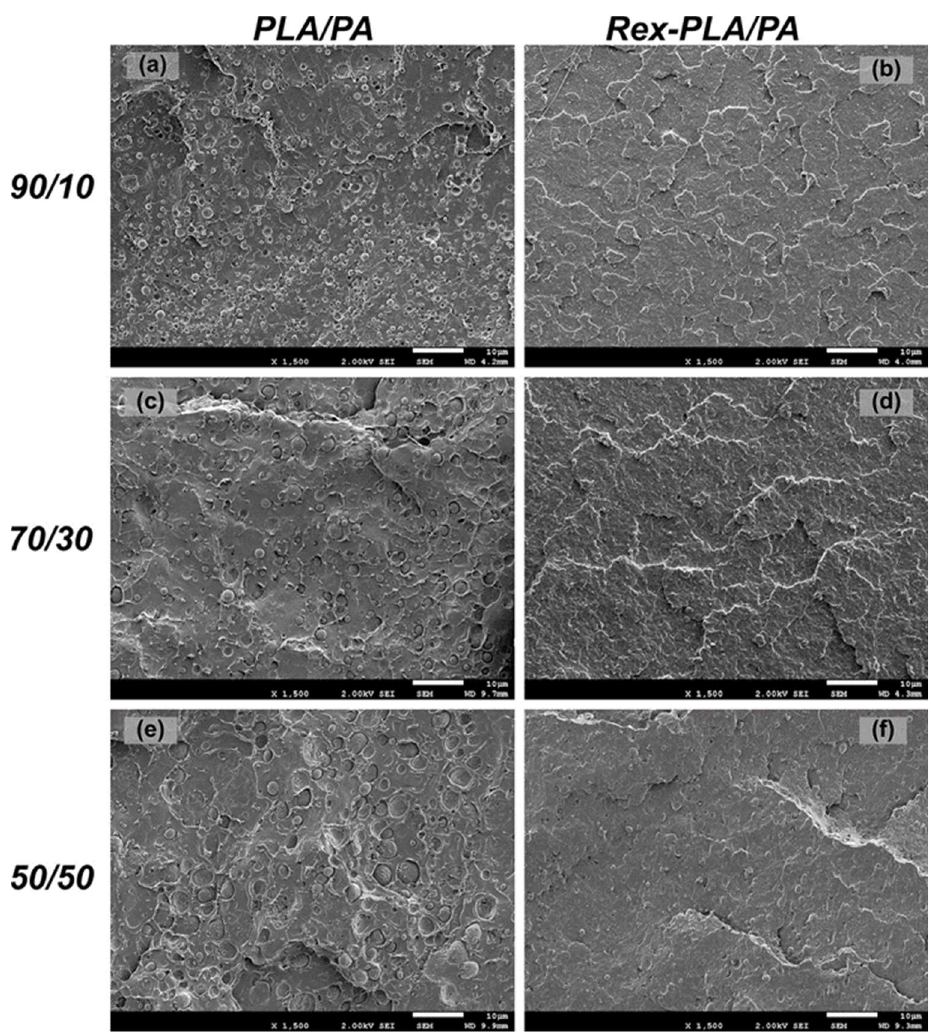
Figure 8. SEM micrographs (×1500) of the cryogenic fractured surfaces of bioblends at various compositions, with and without reactive extrusion. Scale bars = 10 μm. Images ( a , c , e ) correspond to bioblends without reactive extrusion of PLA for 10, 30 and 50% of PA, respectively. Images ( b , d , f ) correspond to bioblends with reactive extrusion of PLA for 10, 30 and 50% of PA, respectively.